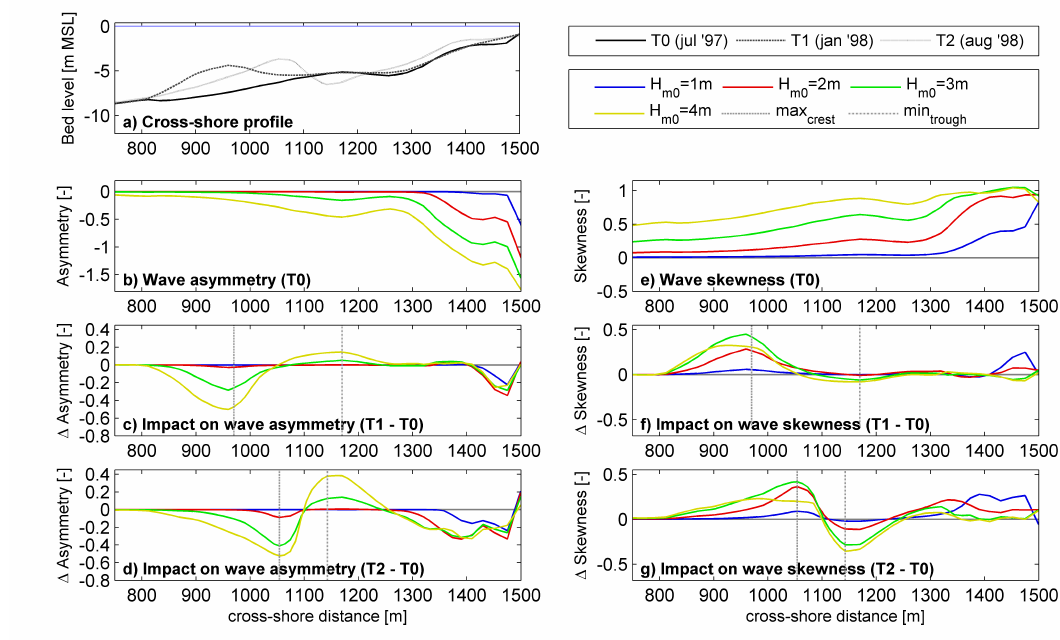
Figure 18. Modelled relative impact of Ter Heijde’97 shoreface nourishment on the wave skewness and asymmetry for January and August 1998 bathymetries (T1 and T2) with respect to the pre-nourishment situation (T0). ( a ) bathymetry for T0 to T2; ( b ) wave asymmetry for T0 situation; ( c , d ) impact on wave asymmetry for time instances T1 and T2; ( e ) wave skewness for T0 situation; ( f , g ) impact on wave skewness for time instances T1 and